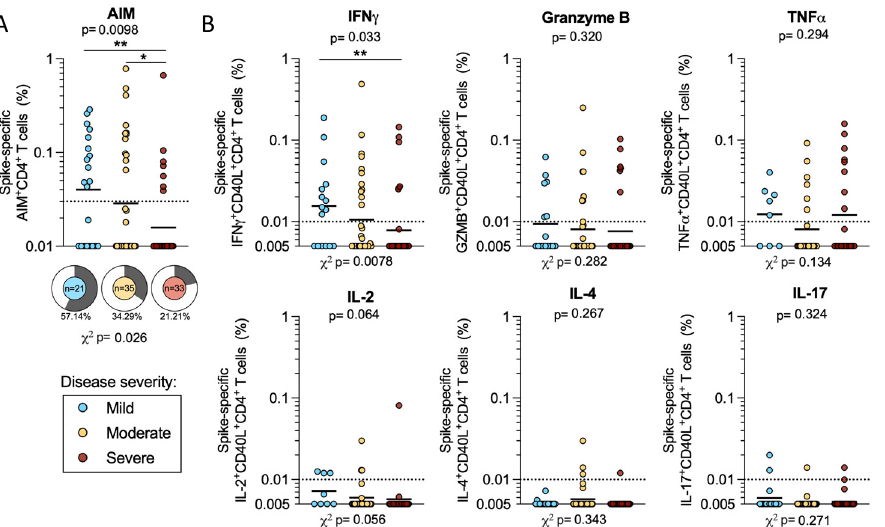
Figure 2. CD4+ T cell responses to SARS-CoV-2 spike in mild, moderate, and severe COVID-19 donors. PBMCs from mild ( n = 21, blue), moderate ( n = 35, yellow), and severe ( n = 33, red) acute COVID-19 donors were tested for CD4+ T cell responses to SARS-CoV-2 S by AIM + ICS assay. ( A ) AIM CD4+ T cell responses were measured by the co-expression of OX40 and CD69. The frequency of response is shown by pie charts. ( B ) The spike-specific cytokine+ CD4+ T cells were measured by the cells expressing CD40L in combination with production of IFN γ , granzyme B, TNF α , IL-2, IL-4, or IL-17. All T cell data shown are background subtracted and SI > 2. Horizontal lines represent the geometric mean and the dotted line represents the limit of sensitivity (LOS), while the y-axis starts at the limit of detection (LOD). p- values are calculated by Kruskal–Wallis One-way ANOVA and, when significant, further Mann–Whitney U tests are applied between disease severities. Chi-square test ( 𝛘 2 ) p- values are indicated below the pie charts and are calculated from the frequency of response. * p < 0.05, ** p < 0.01.